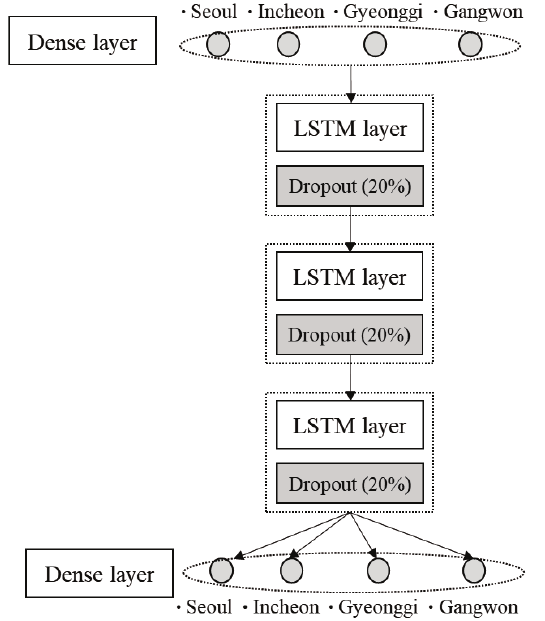
Figure 5. Neural network